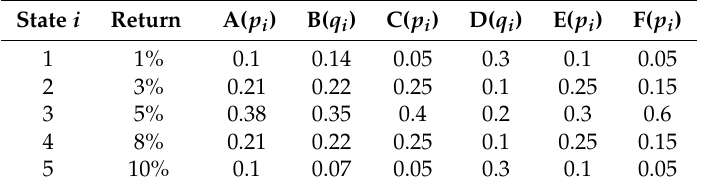
Table 2. The returns of assets A-F with 5 states and their associated